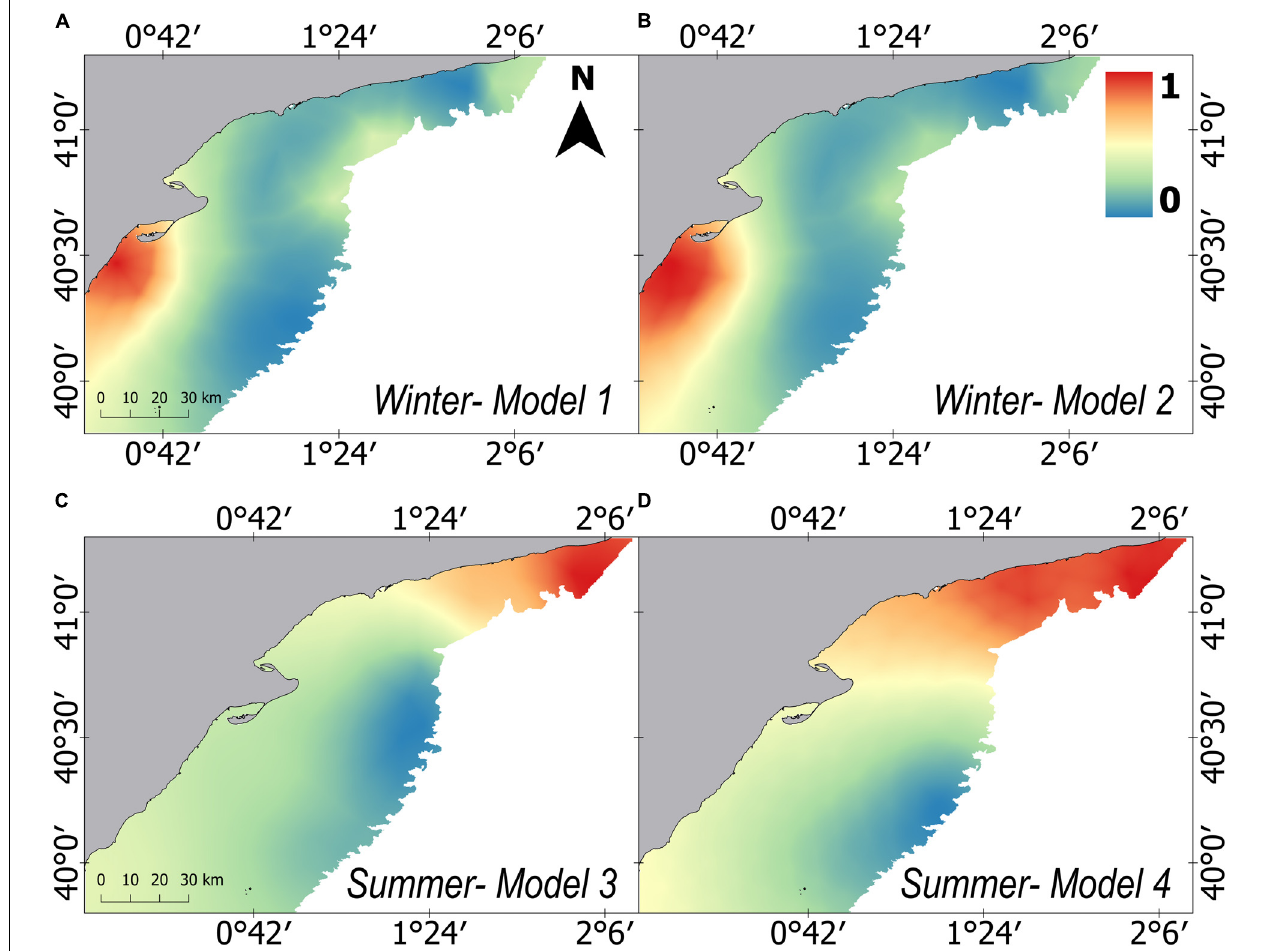
FIGURE 3 | Predicted distribution of the posterior mean of the relative mean weight (kg/n) for European hake in winter (A,B) and summer (C,D) for each one of the four models developed. Model 1 and Model 3 consider prey explanatory variables on abundance measure, whereas Model 2 and Model 4 include prey explanatory variables on mean weight measure. All results have been standardized and share a common scale ranging from 0 to